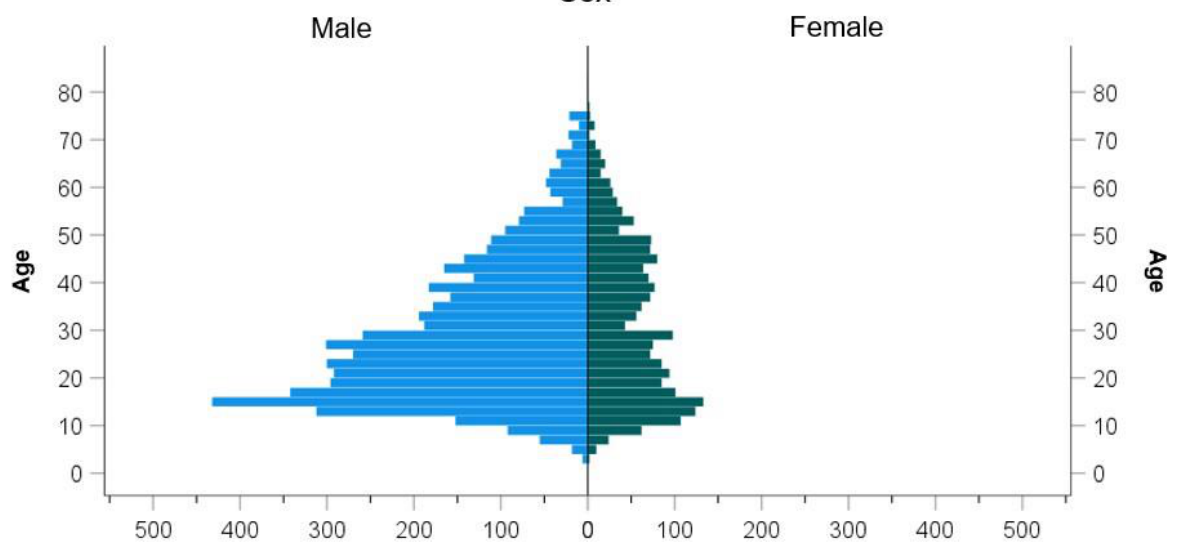
Figure 1. Distribution of injuries by gender and age .